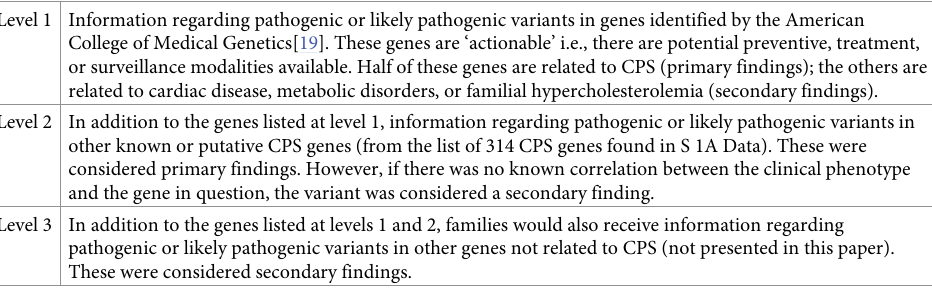
150-bp reads and 30 × average coverage. Reads were mapped to the hg19 reference genome